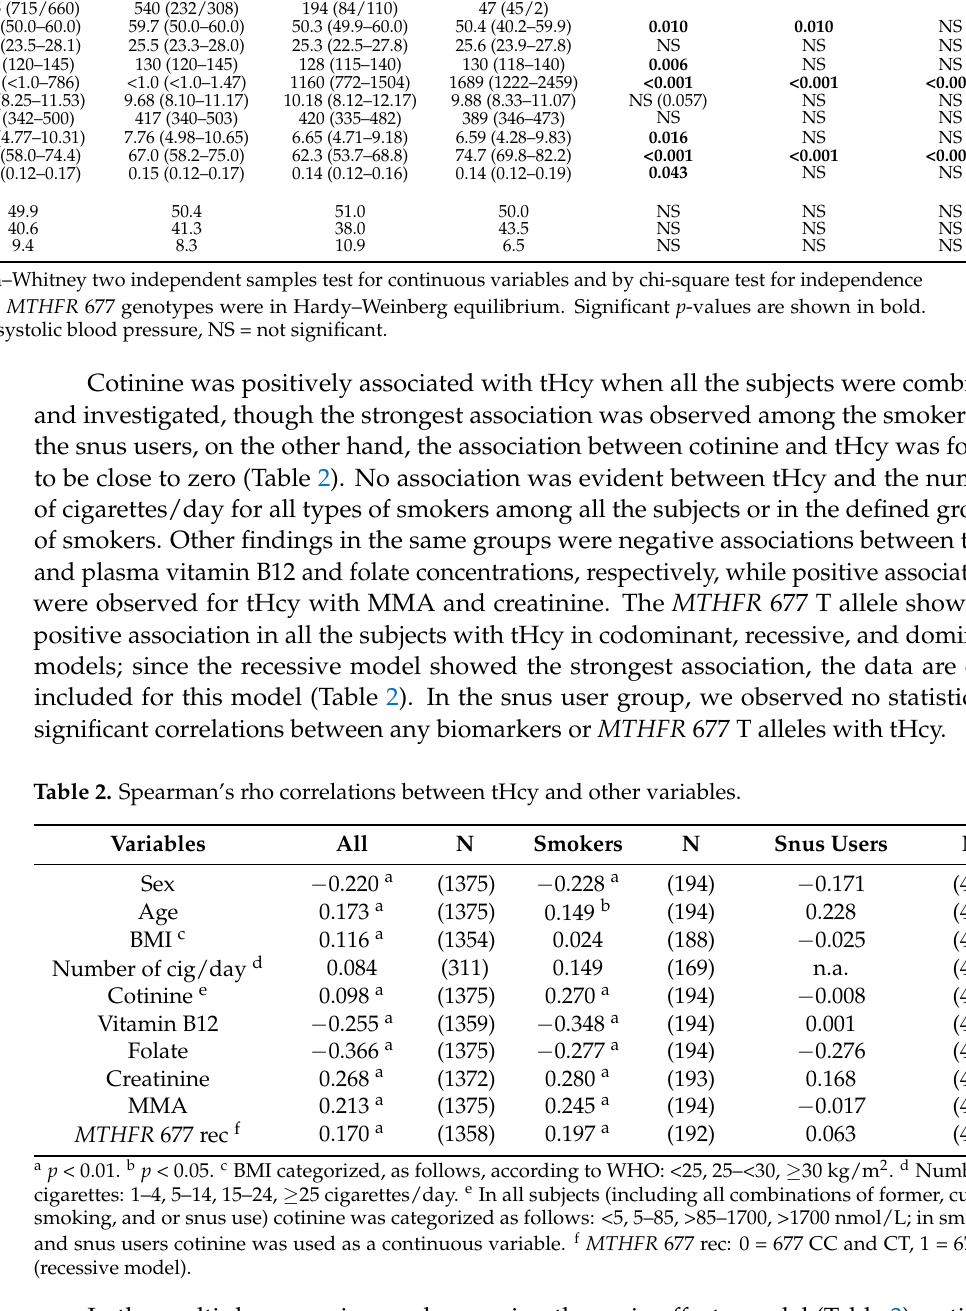
Table 1. Characteristics presented as medians (25–75%) for continuous variables and as proportions/percent for categorical variables for all subjects with cotinine data, and strictly defined groups of never tobacco users, smokers and snus users. Variables